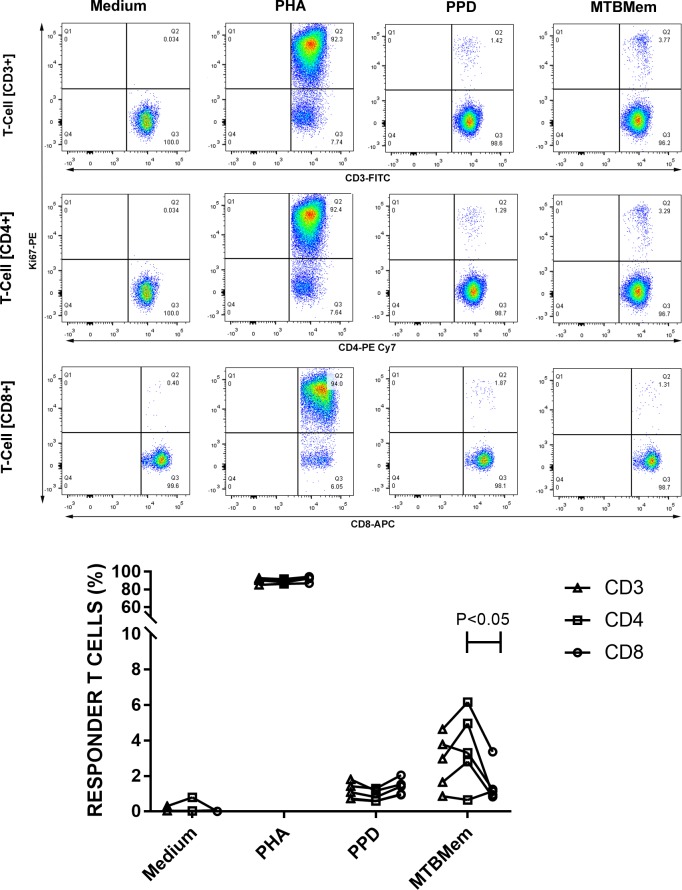
Proliferative responses of T cells (CD3+) and T cell subsets (CD4+ and CD8+) to MTB antigens (PPD and MTBMem) or controls (medium and PHA).Top Panel: Representative flow plots for one of the HCWs. In each plot, upper right quadrant houses the responder (Ki67+) cells. Bottom Panel: Individual T cell responses (key) of 5 HCWs. P value for the lone difference is shown.